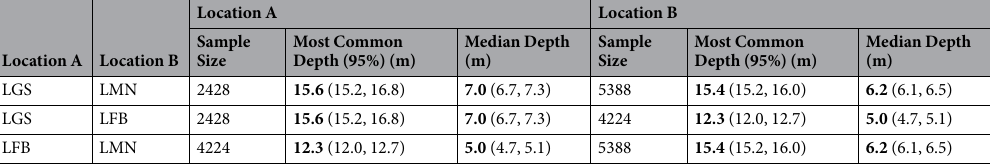
Table 1. Median depth at which all subyearling Chinook salmon were detected within the forebays of LGS and LMN and at LFB during 2013. 95% CI are listed in parentheses. The depth at which 95% of the fish were found at or were shallower than is also shown. All of the comparisons of depth distribution between two locations were significantly different (P <